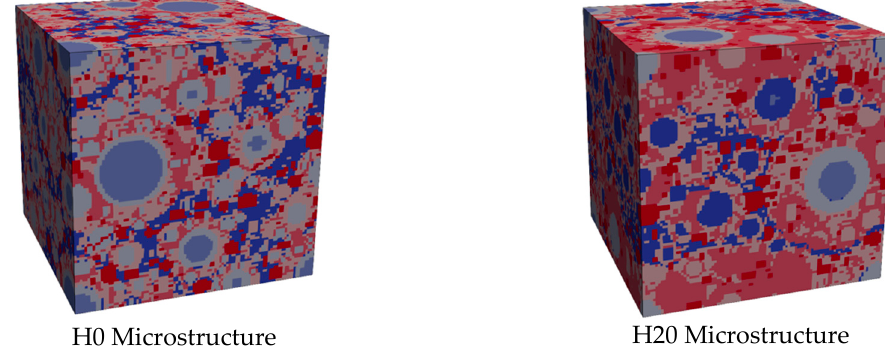
Figure 4. Impression of the two virtual microstructures employed in this research.